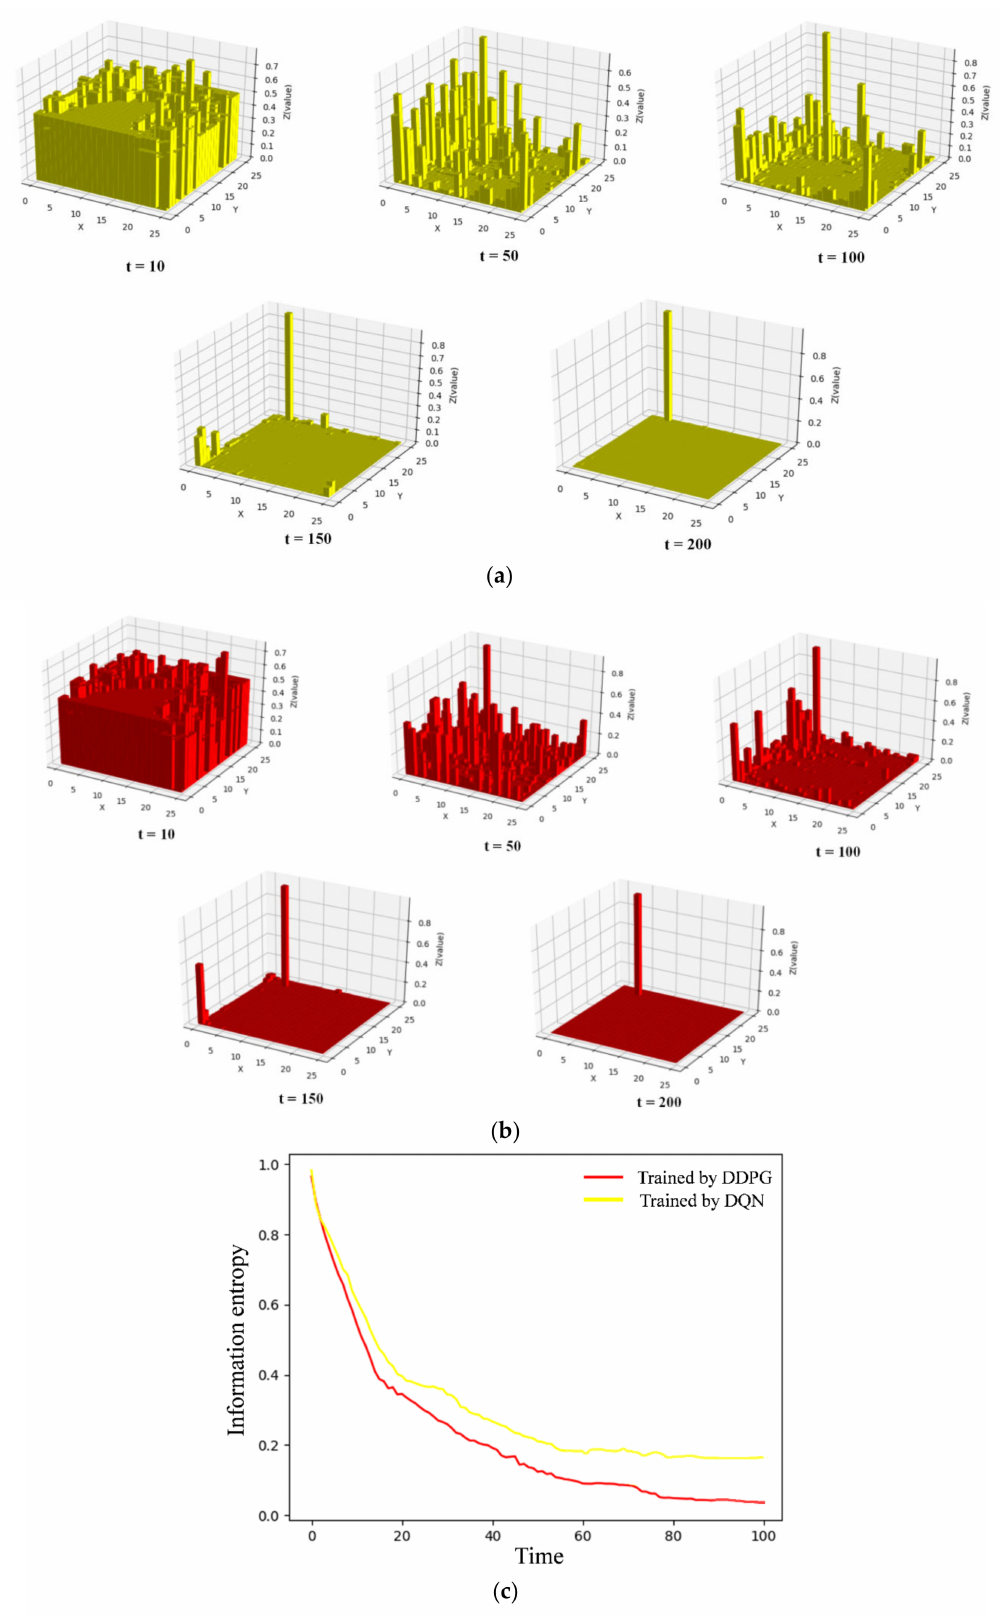
Figure 6. ( a ) The probability map of the deep Q-network (DQN). ( b ) The probability map of the deep deterministic policy gradient algorithm (DDPG). ( c ) Information entropy of the DQN and